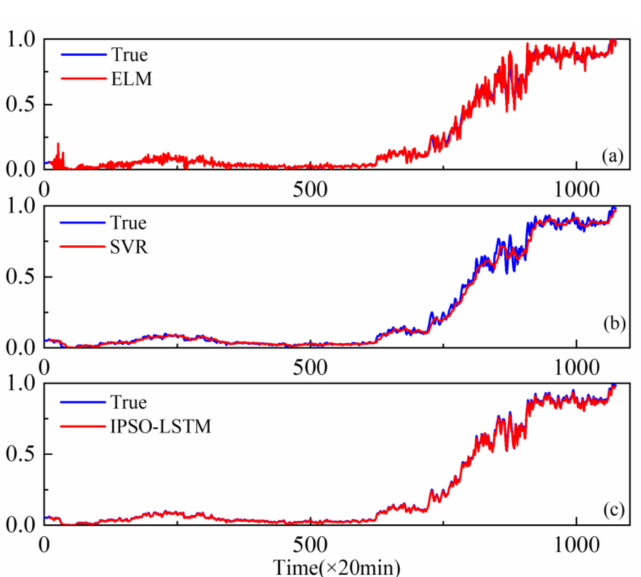
Figure 10. Performance degradation predictions of the outer bearings for the: ( a ) ELM; ( b ) SVR; ( c ) IPSO-LSTM.